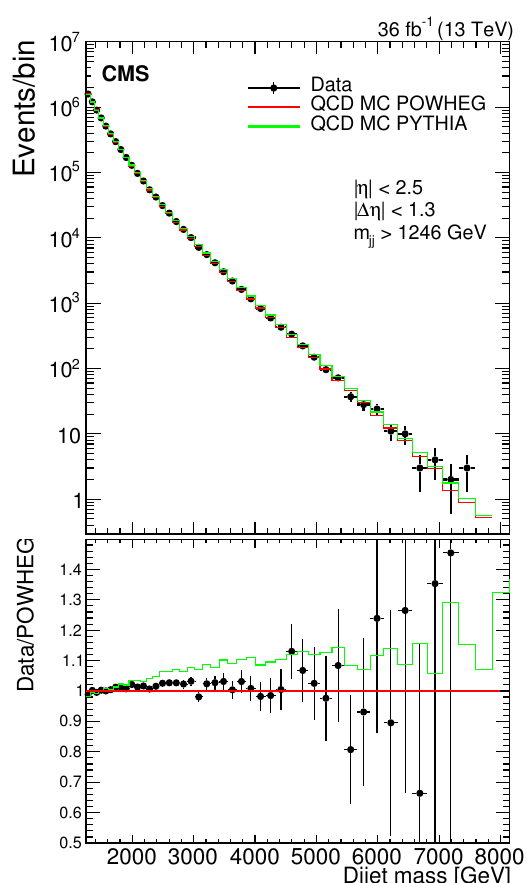
Figure 6 . The dijet mass distribution of the two wide jets from the high-mass search. (Upper) Data (points) are compared to predictions from the powheg MC in red (darker) and the pythia 8 MC in green (lighter), including detector simulation, each normalized to the data. (Lower) The ratio of data to the powheg prediction, compared to unity and compared to the ratio of the pythia 8 MC to the powheg prediction. The horizontal lines on the data points show the variable bin